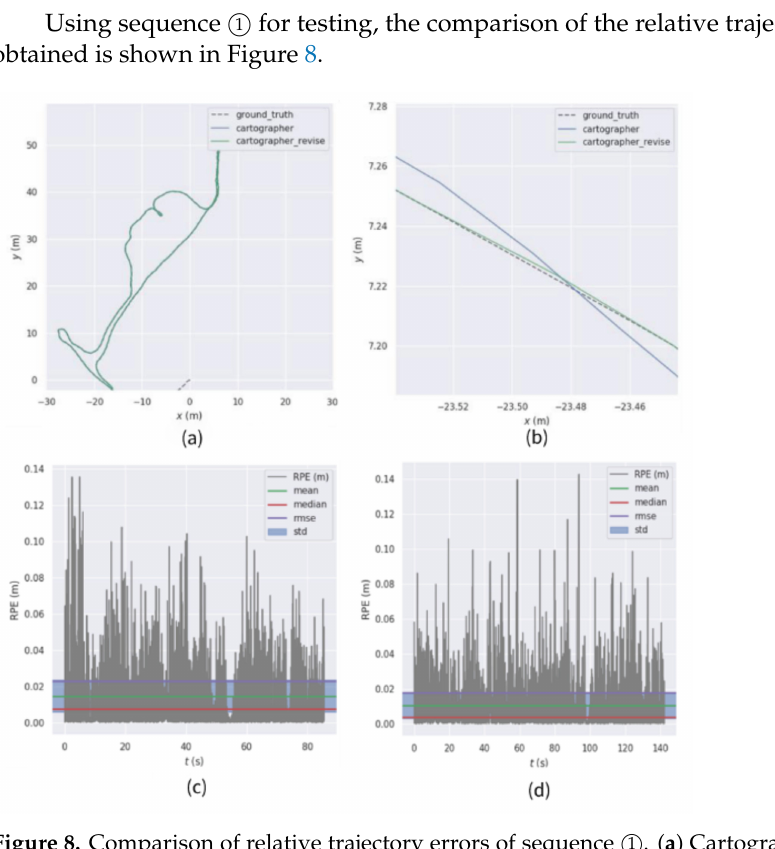
Figure 8. Comparison of relative trajectory errors of sequence 1 (cid:13) . ( a ) Cartographer, improvement scheme, and real trajectory comparison ( b ) Local trajectory map ( c ) Absolute trajectory error of Cartographer ( d ) Absolute trajectory error of the improved